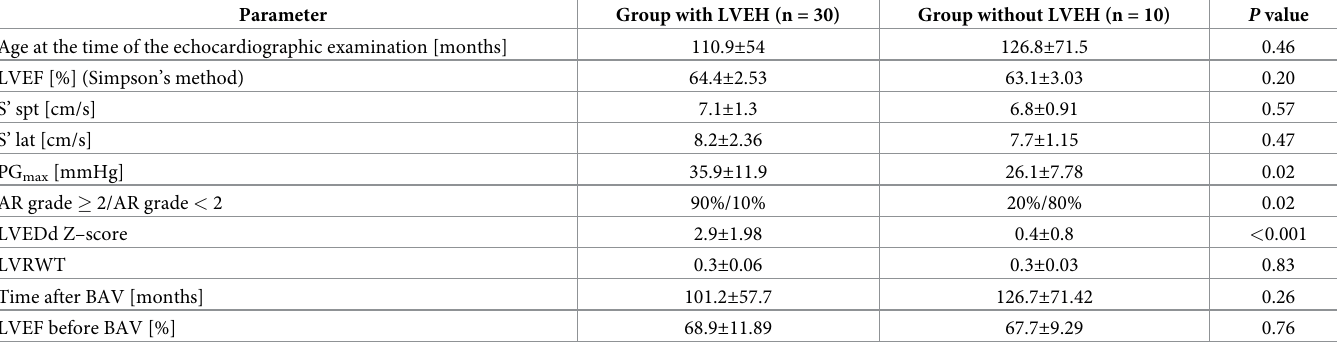
Table 2. Comparison of selected parameters in subgroups: With and without left ventricular eccentric hypertrophy. Parameter Group with LVEH (n = 30) Group without LVEH (n = 10) P